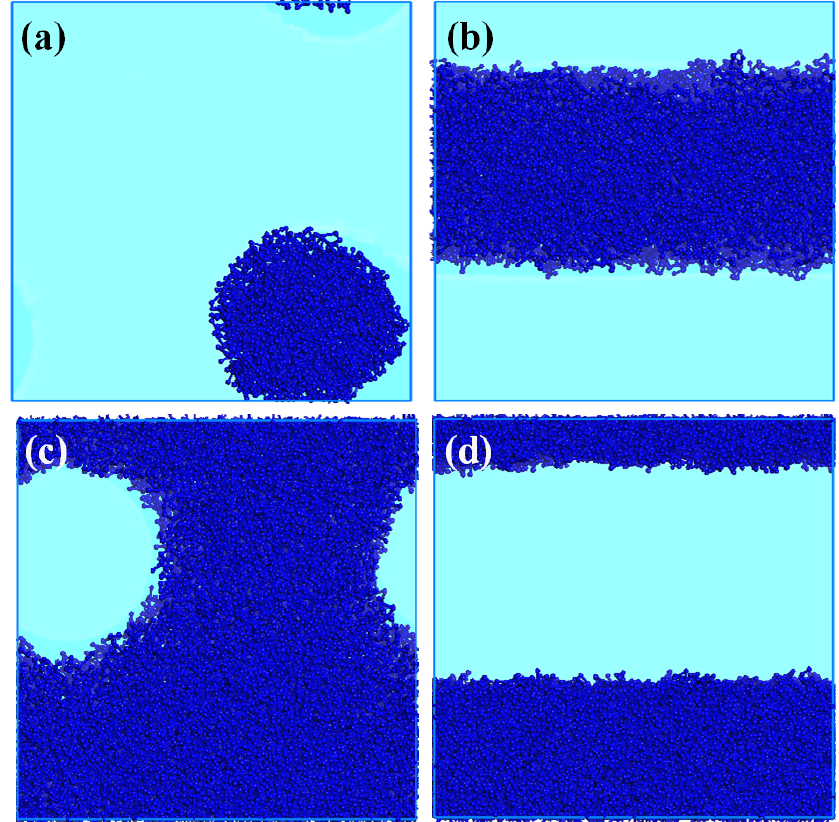
Figure 4. Phase regions with the DPD calculated phases at T = 298.15 K and water: NPE-15 ratio: ( a ) 1:0.05, ( b ) 1:0.25, ( c ) 1:0.5 and ( d ) 1:0.75. In all the Figures, ball and sticks represent the surfactant